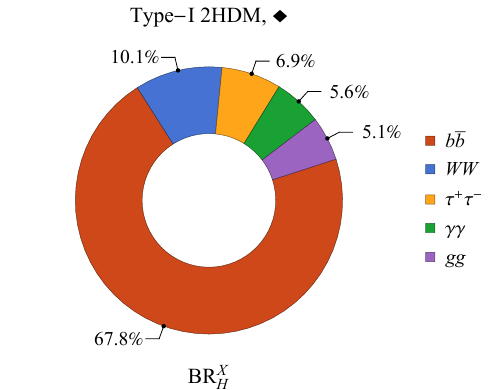
Figure 3 . Left: percentage breakdown per production process of H at branching ratios of H . Only (cid:27) X charts correspond to the type-I 2HDM benchmark scenario